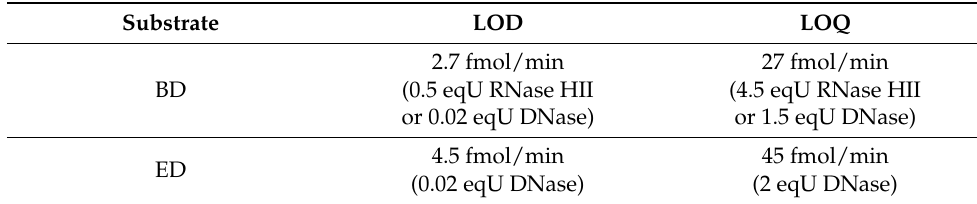
Table 3. Limit of detection (LOD) and limit of quantification (LOQ).